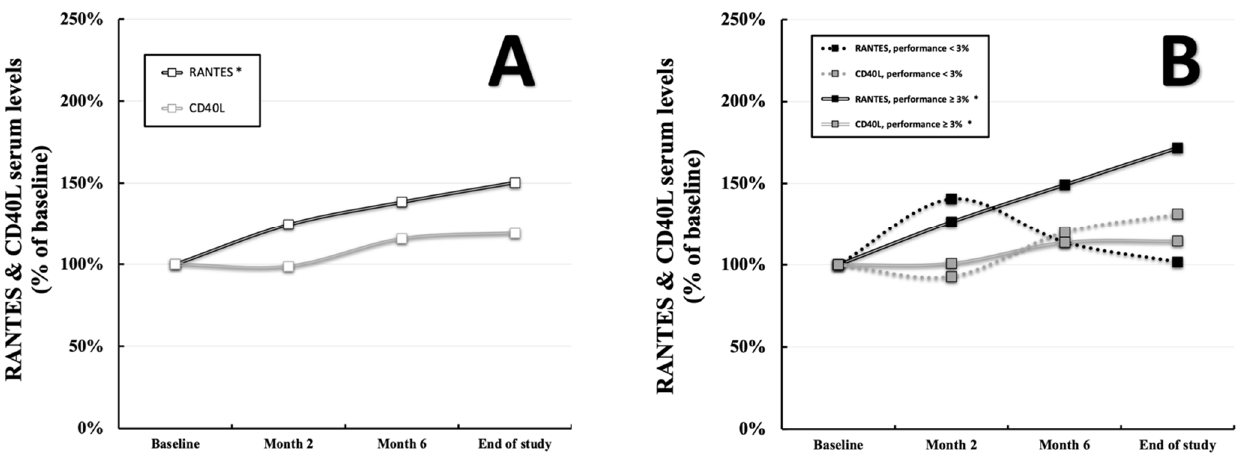
Figure 1. Progression of RANTES and CD40L serum levels within the total population ( A ) as well as the groups A (performance gain of <3%, n = 27, ( B )) and B (performance gain of ≥ 3%, n = 71, ( B )) over the course of 8 months. “*” indicates a two-tailed p -value of p < 0.05 comparing baseline values to those at the end of the study.